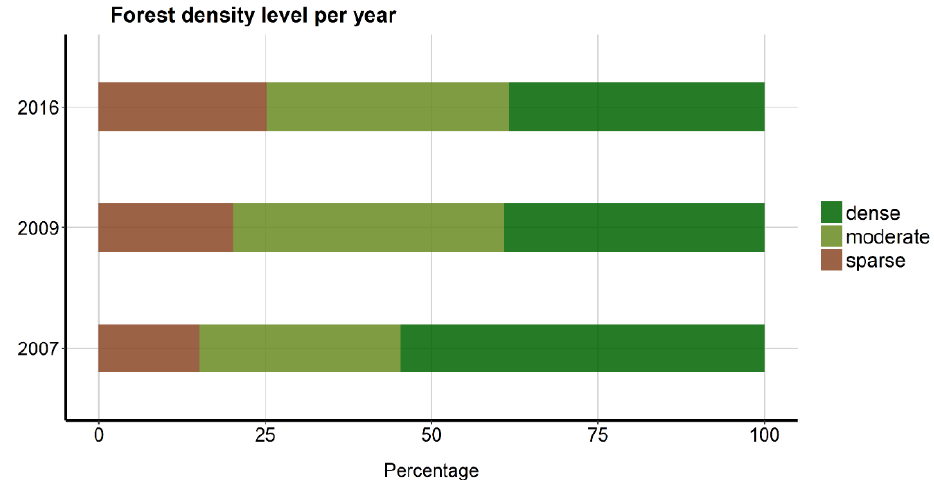
Figure 4. Percentage of the level of forest degradation per year, natural Forest = >200 t/ha, degraded = 50–200 t/ha, and highly-degraded = 0–50 t/ha AGB.